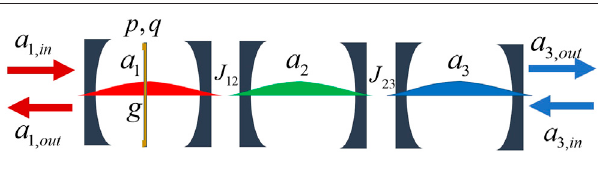
FIGURE 1 | (Color online) Schematic of an optomechanical system consisting of three cavities described by optical modes a 1 , a 2 , and a 3 as well as a membrane described by position q and momentum p . This system could be driven by an input fi eld a 1, in and exhibit an output fi eld a 3, out , or driven by an input fi eld a 3, in and exhibit an output fi eld a 1, out . Here, g denotes the optomechanical coupling strength, while J lk represents the coupling strength between optical modes a l and a k